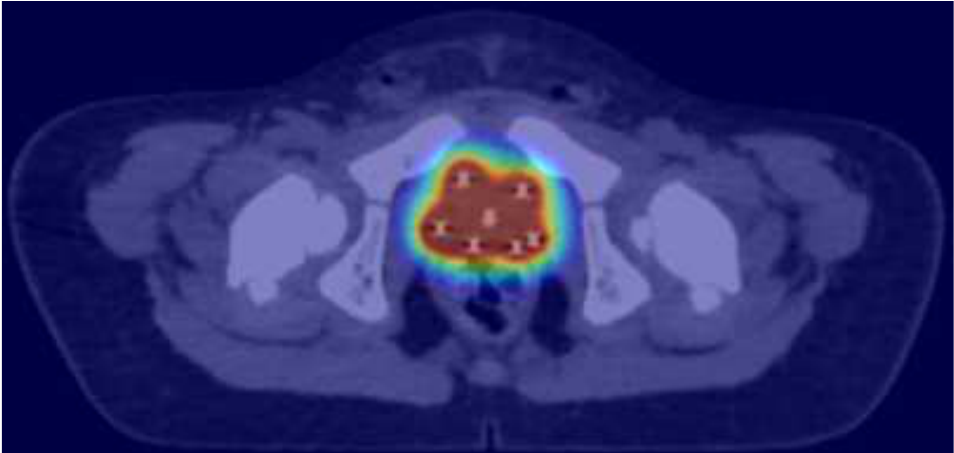
Figure 1. Brachytherapy dose distribution of intraoperative/trans-perineal brachytherapy implant for the treatment of bladder neck/prostate rhabdomyosarcoma: the red isodose surface corresponds to 100% of the prescribed dose, the yellow to the 80%, the green to the 50% and the dark blue to the 25%, respectively.